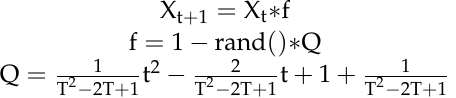
After the dandelion seeds have reached a certain distance, it is time for the descending stage. In this part, the movement of dandelion seeds based on Brownian motion ( β t ) is expressed with a normal distribution, so that it can be obtained from the average position information after the rising stage. Therefore, the new position of the dandelion seeds in this step is calculated through Equation (47).